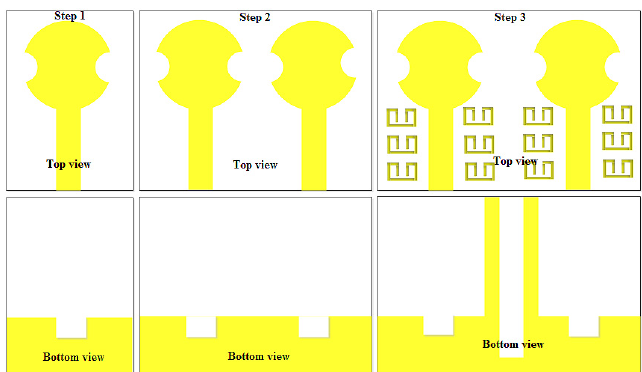
Figure 4. Evolution stages of the proposed UWB/MIMO antenna.